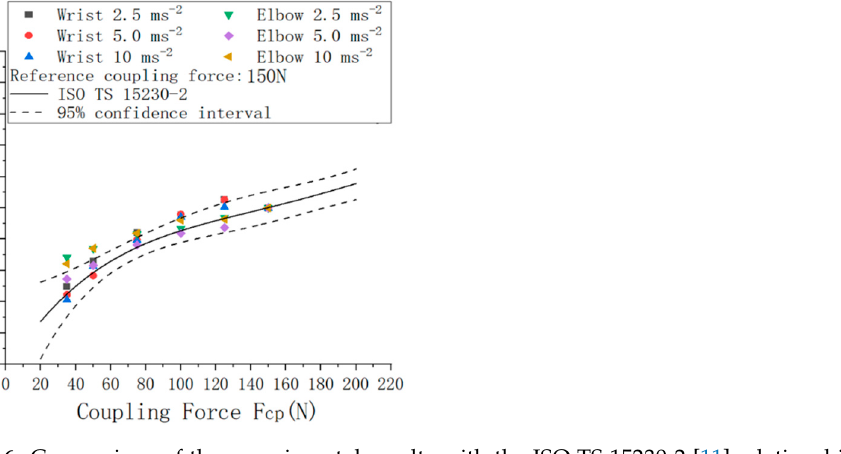
Figure 6. Comparison of the experimental results with the ISO TS 15230-2 [11] relationships and corresponding 95% confidence intervals for the various values of the reference coupling force.